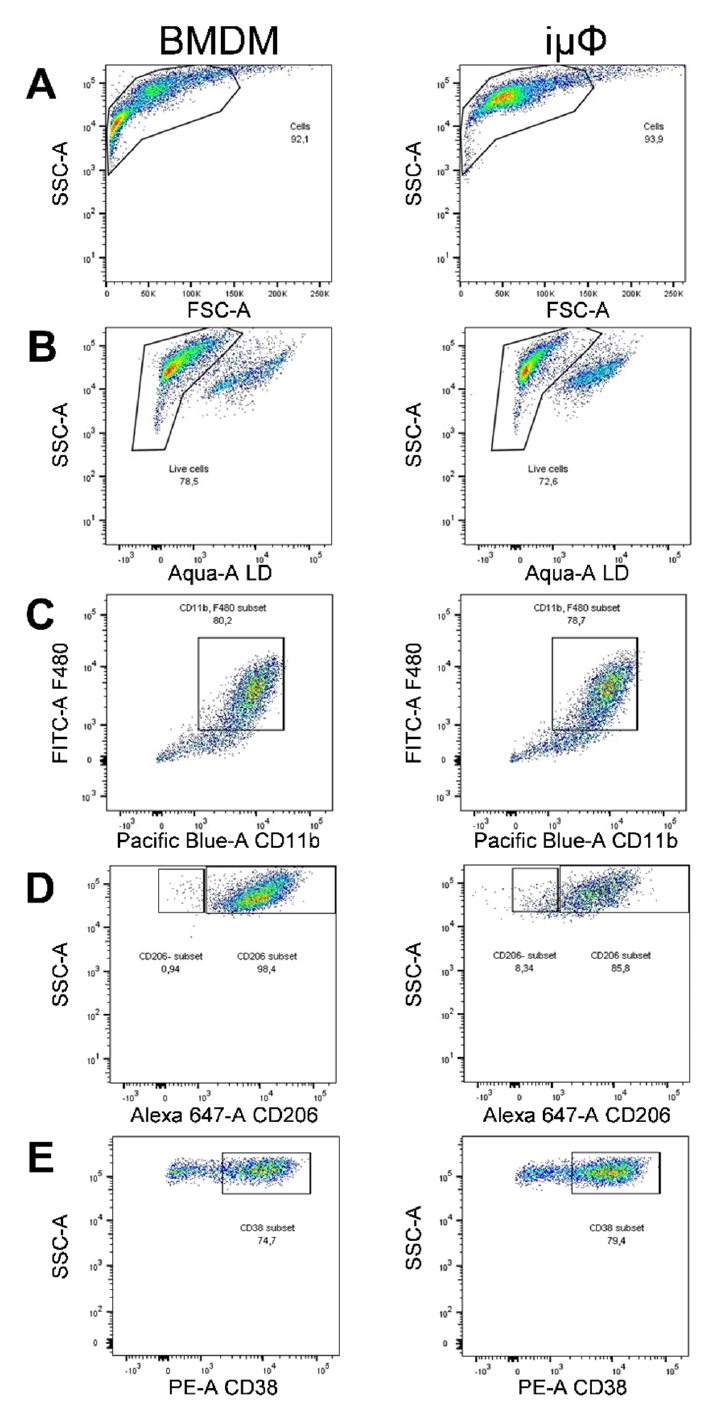
Figure A1. Gating strategy for FACS macrophage characterization. ( A ) BMDM and immortalized macrophages (iµФ) in their naïve form (MΦ) were selected according to morphology and granulocity (SSC-A vs. FSC-A) and data were plotted using FlowJo software. Inside of the plot, live cells were discriminated by Aqua staining ( B ) Live macrophages were identified as double-positive CD11b and F4/80 events ( C ) BMDM and iµФ were polarized with IL4 (40 ng/mL) to M2 or with LPS (500 ng/mL) and IFNγ (25 ng/mL) to M1 and the surface markers CD206 (M2, ( D )) and CD38 (M1, ( E )) were plotted.